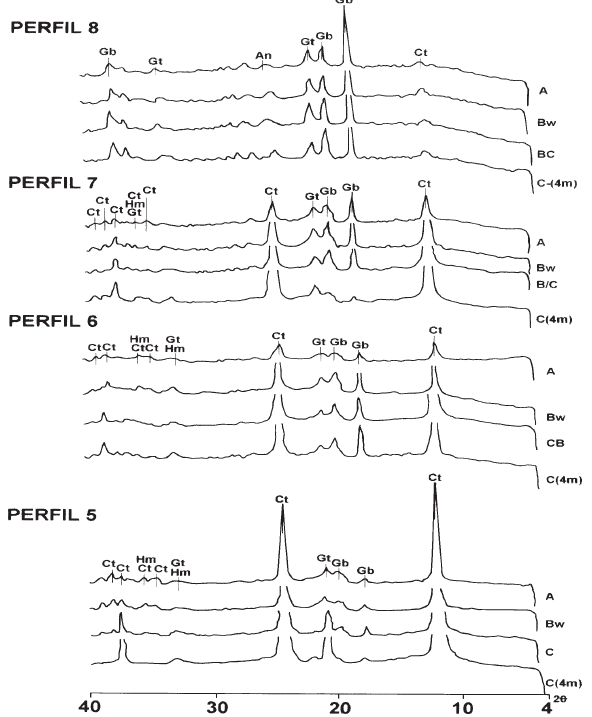
Figura 3. Difratogramas de raios X da fração argila dos perfis 5, 6, 7, e 8, sem pré-tratamento, com lâminas